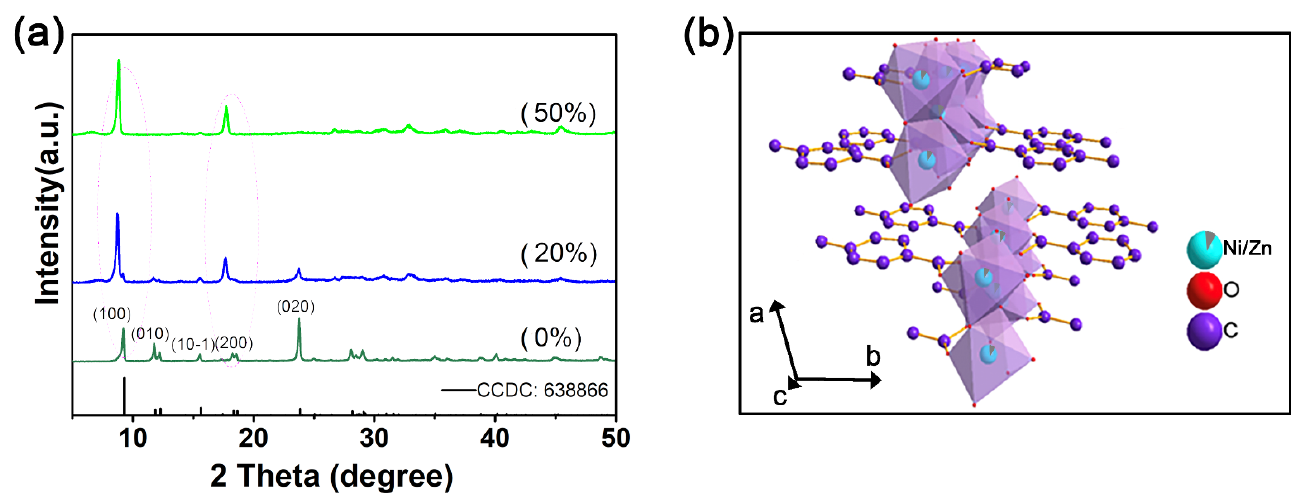
Figure 1. ( a ) Powder XRD pattern of the different atom fraction Zn x -Ni-PTA samples. ( b ) The structure mode of Zn x -Ni-PTA.